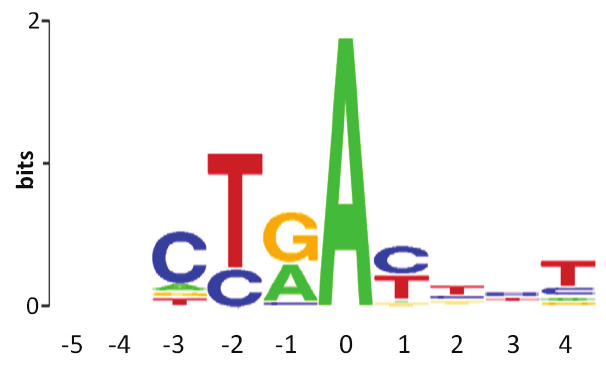
Figure 3. R (b,l) matrix used for the prediction of a variant’s i effect on branch-point sites. Sequence logo for information model for the branch-point site, created using 20 annotated branch-point